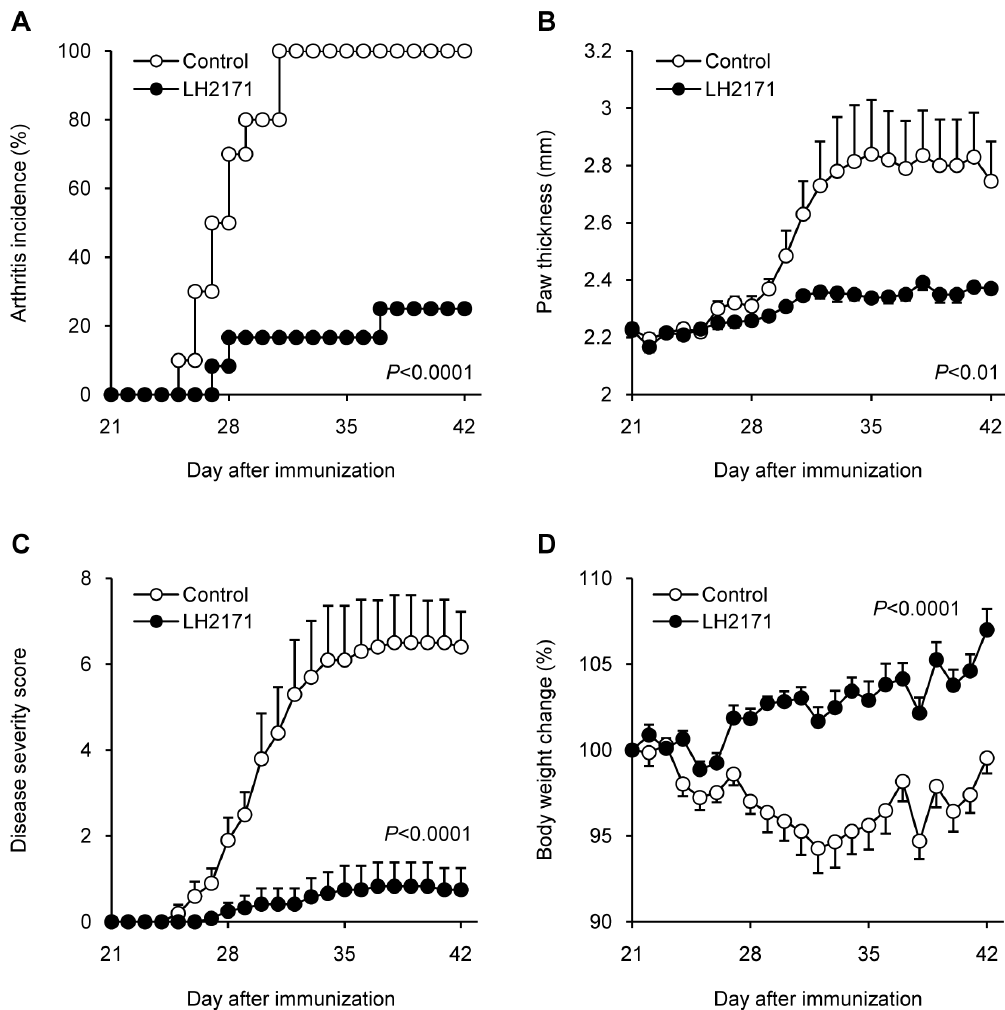
Figure 5. LH2171 alleviated collagen-induced arthritis (CIA) in mice. To induce arthritis, DBA/1J mice (8-week-old) were immunized with an emulsion of 100 m g of bovine type II collagen (CII) which was dissolved in 0.05 M acetic acid and emulsified in Complete Freund’s Adjuvant (CFA), and with repeated immunization after 21 days. LH2171 group mice were administered with 1 mg heat-killed Lactobacillus helveticus SBT2171 (LH2171) by the intraperitoneal injection three times a week after the first immunization and daily after the second immunization. The control group mice were administered PBS with the same frequency. After the second immunization, mice were observed for measurement of arthritis incidence (A), disease severity score (B), paw thickness (C), and body weight change (D). Data are expressed as means 6 SEM (n=0) and compared with the control group by log-rank test (A) and two-way repeated measures ANOVA (B, C, D).